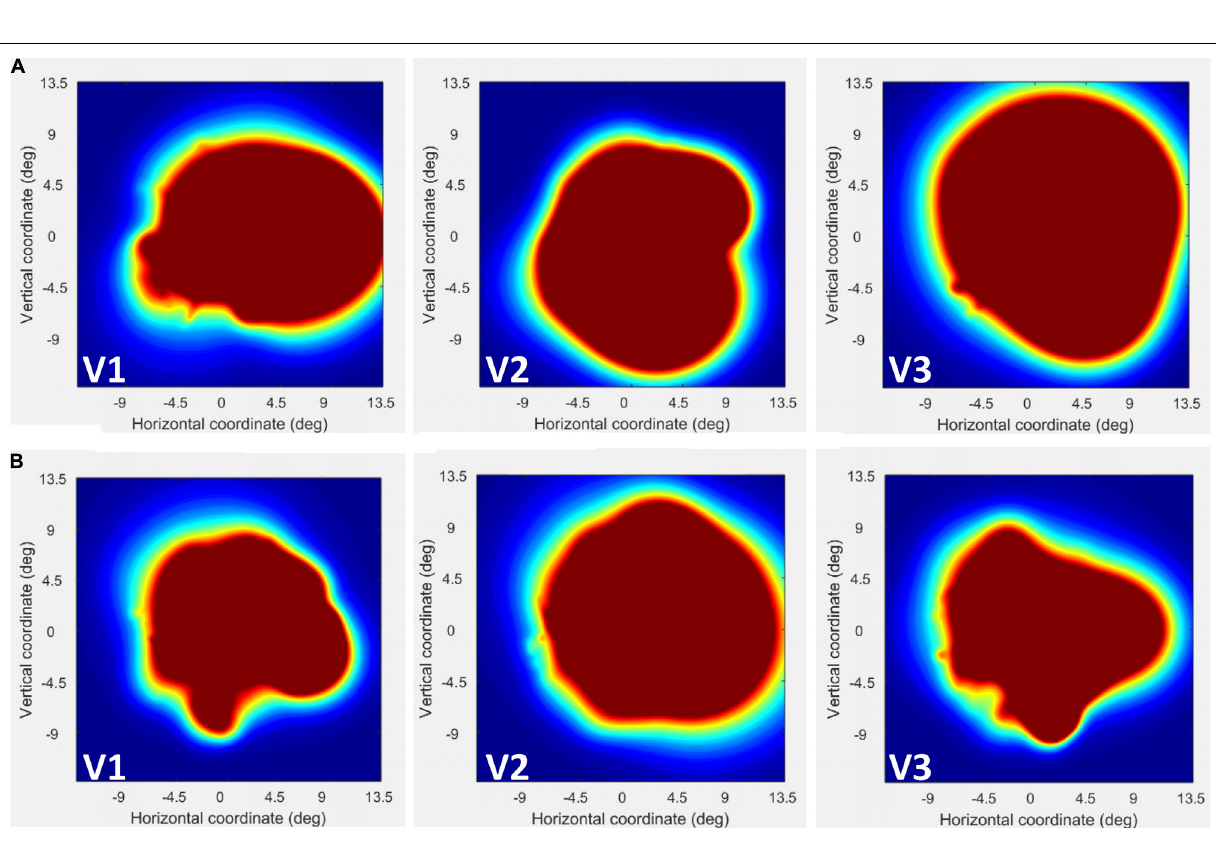
Frontiers in Psychology |